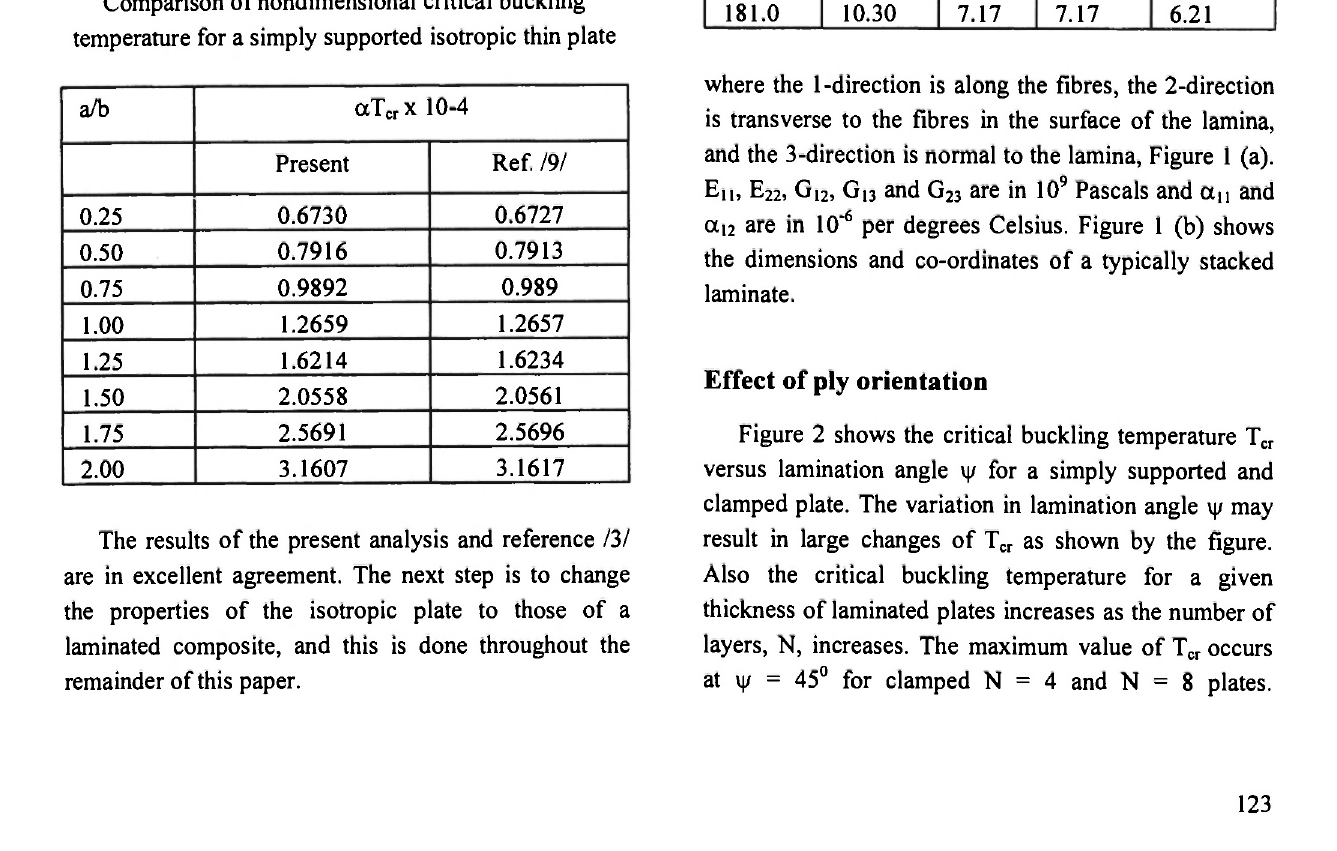
Comparison of nondimensional critical